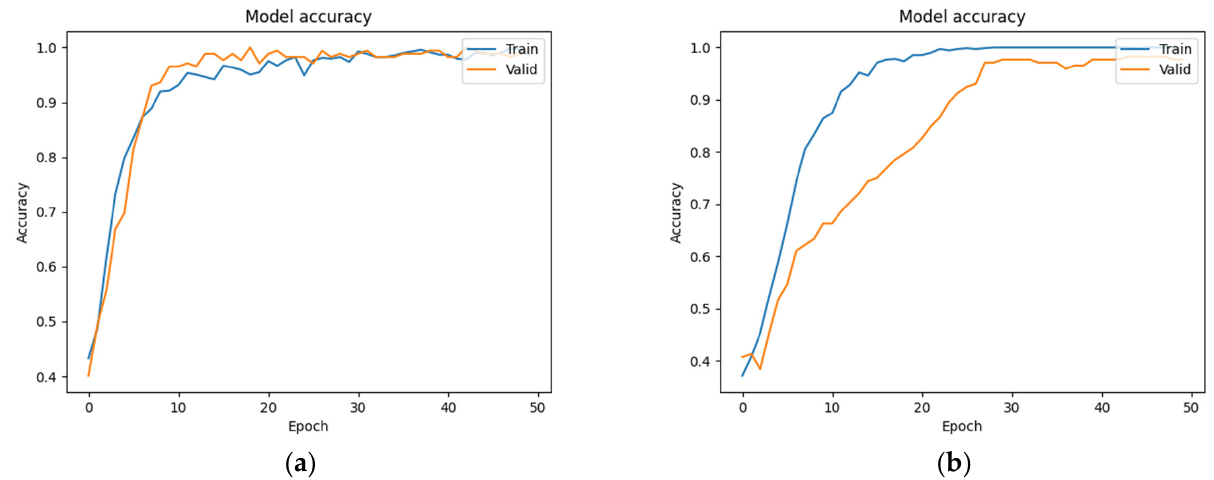
Figure 8. ( a ) Training accuracy using data augmentation. ( b ) Training accuracy without data augmentation.